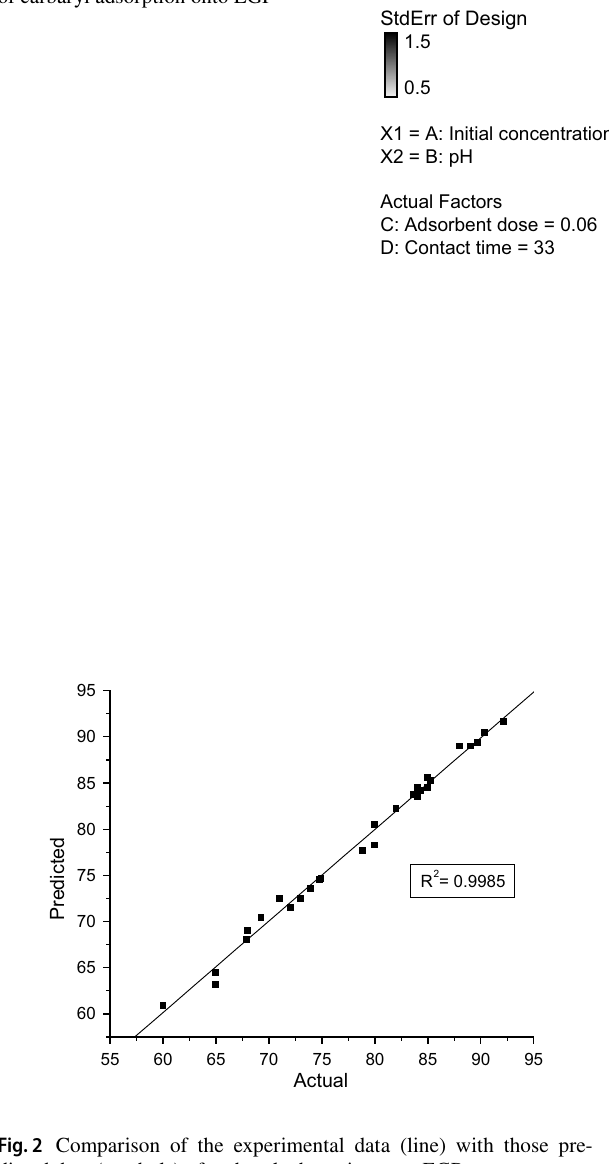
Fig. 1 Standard error of design